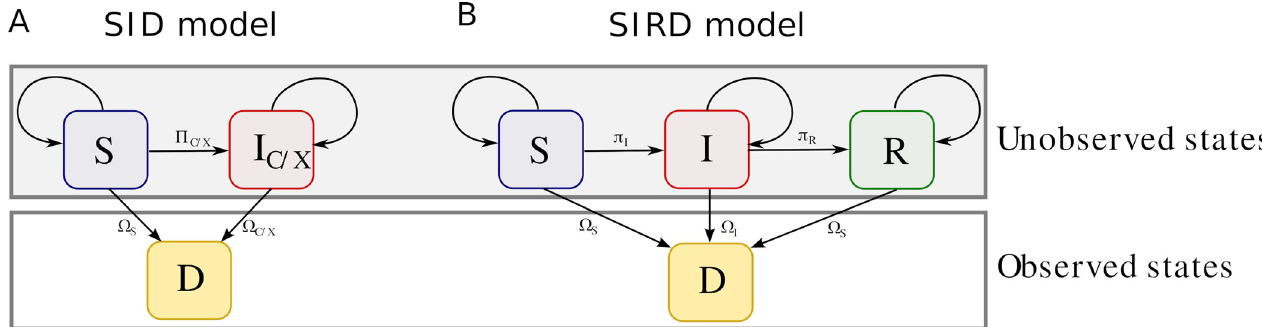
Fig 2. State transitions for the SID model (panel A) and the SIRD model (panel B). Blue boxes denote the susceptible state (denoted as S ). Red boxes in the SID model denote the infected state including either DCV ( I C ) or DXV ( I X ). The red box in the SIR model is the state for individuals infected with phocine distemper ( I ), while the green box is the recovered state ( R ). The probability of death is denoted as O ( t ), with appropriate subscript, and the probability of transitions from one state to another are denoted with Greek letters. Lines that begin and end in the same state denote the proportion of individuals that stay in the same state the following time step. Thus, in the SID model the probability of remaining in state S from time t − 1 to time t is 1 − O S ( t ) − P absorbing state, all individuals remain in this state.